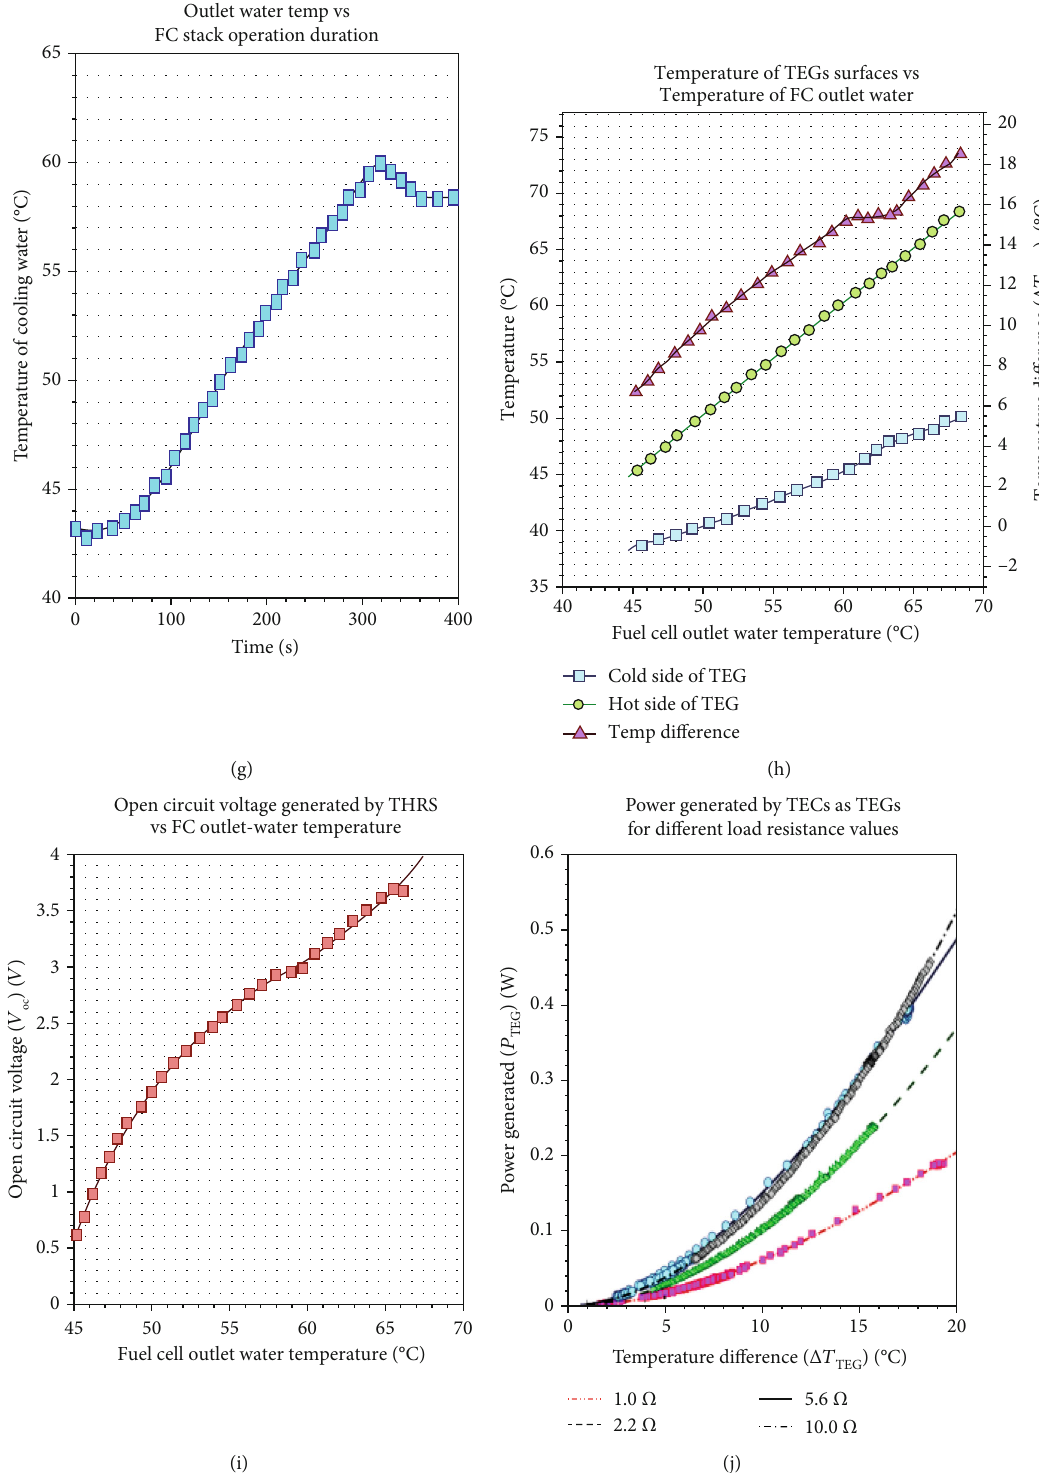
Figure 13: TECs as TEGs with 5 kW LT-PEM FC waste heat recovery system (adapted from